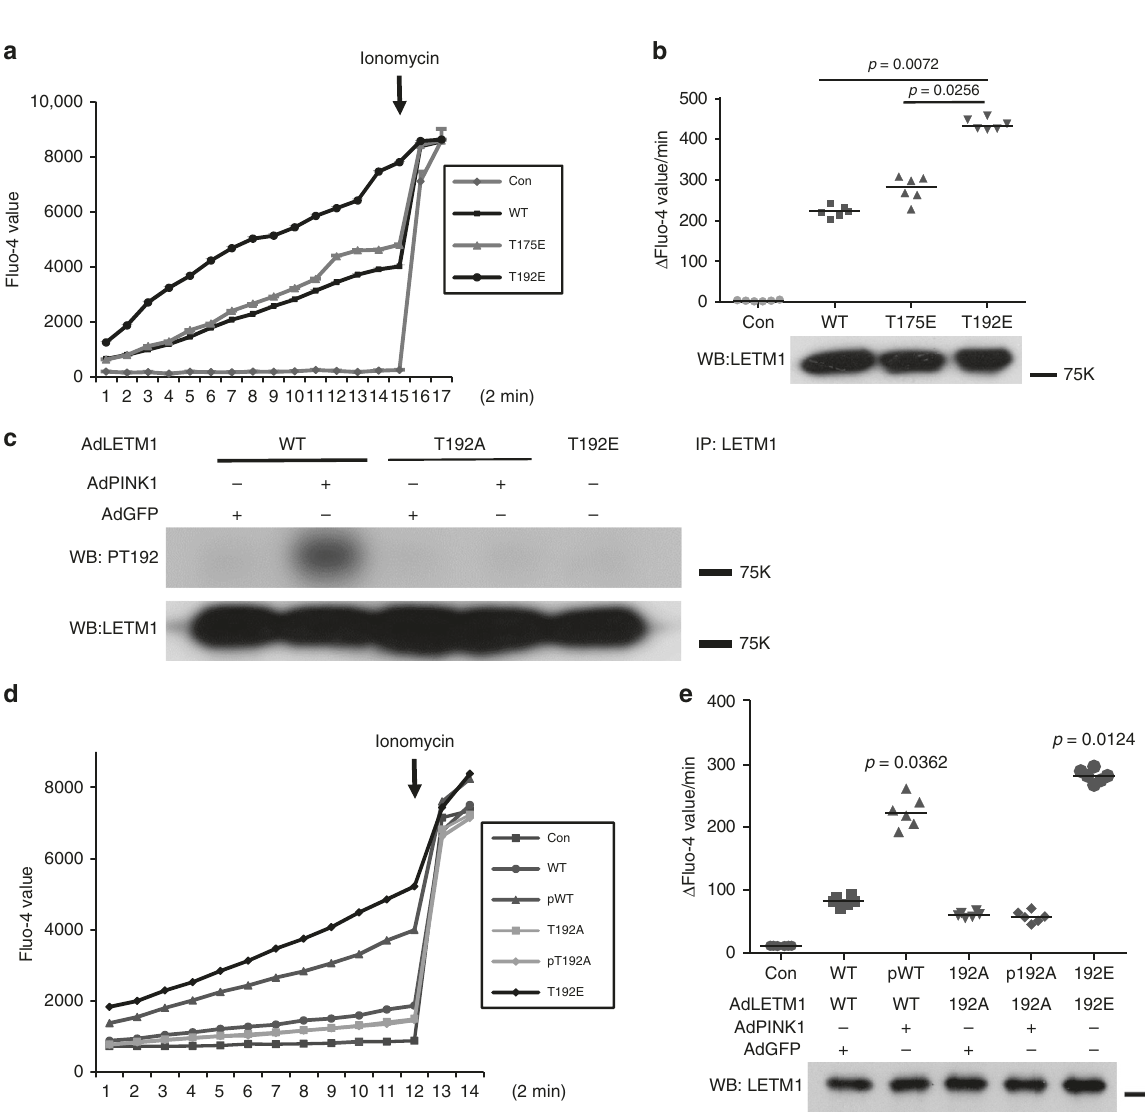
Fig. 3 The effect of PINK1-mediated phosphorylation of LETM1 on liposomes calcium release activity in vitro. a About 1 µ g puri fi ed bacterial full-length His- LETM1-WT, T175E, and T192E were incorporated into liposomes and subjected to calcium release assay. Control (Con) indicates no proteins incorporated. b (top panel) Quanti fi cation of calcium release activity measured by rate of calcium release and calculated as change of fl uorescence unit ( Δ F ). n = 6. (bottom panel) The liposome samples in a were analyzed by WB with anti-LETM1 antibody to show loading of proteins. c HEK293 cells were co- transfected with pAdtrack LETM1 (AdLETM1)-WT or T192A and Adtrack control GFP (AdGFP, WT, T192A) or PINK1 (AdPINK1, pWT, pT192A), and AdLETM1-T192E only for 1 day. The FLAG-LETM1 proteins were isolated by IP with anti-FLAG, probed with pT192 or anti-LETM1 by WB. The experiment was replicated three times. d HEK293 cells were co-transfected with AdLETM1-WT or T192A and AdGFP or AdPINK1, and AdLETM1-T192E only for 1 day. The FLAG-LETM1 proteins were isolated by IP with anti-FLAG and eluted by 3XFLAG peptide. The eluted proteins were subjected to calcium release assay using arti fi cial liposomes. Control is without protein incorporated. e (top panel) Quanti fi cation of calcium release activity of d measured by rate of